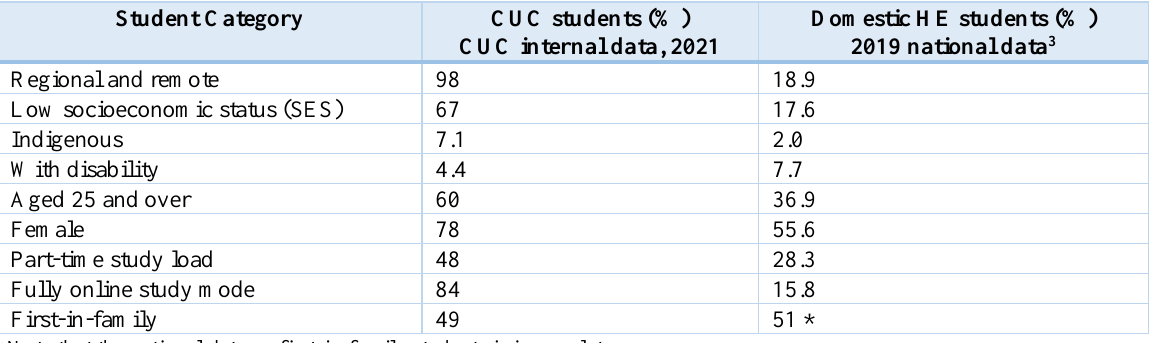
Comparison of CUC and National HE Student